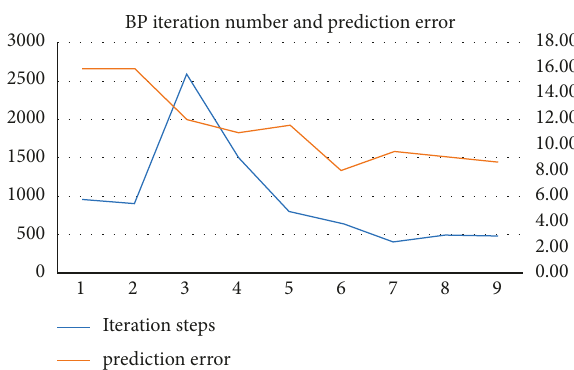
Figure 4: The number of iterations of BP neural network, the number of hidden layer neurons, and the prediction error